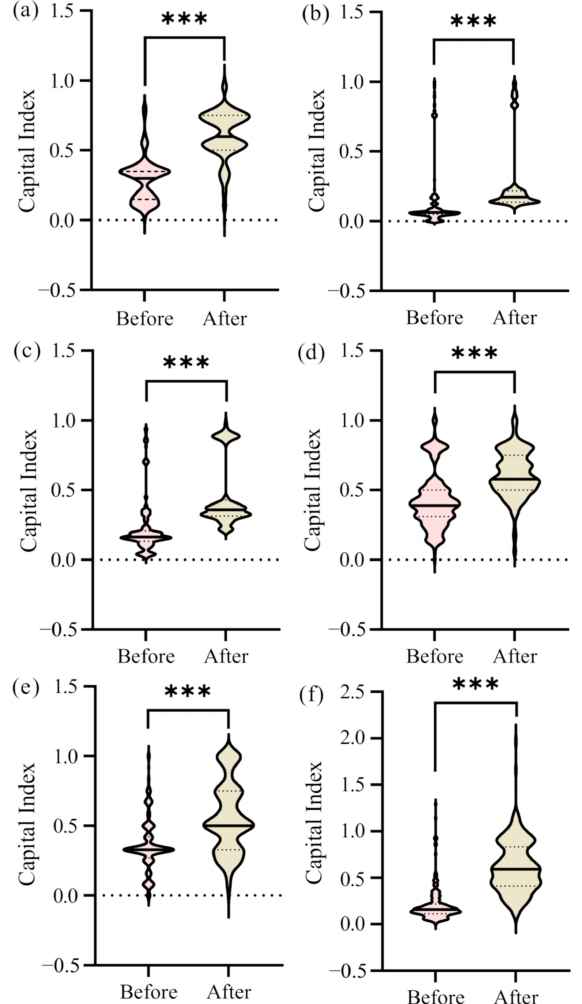
Figure 2. Index of each form of capital before and after policy implementation. ( a ) human capital, ( b ) physical capital, ( c ) financial capital, ( d ) social capital, ( e ) psychological capital, and ( f ) livelihood capital; ***: p < 0.001).